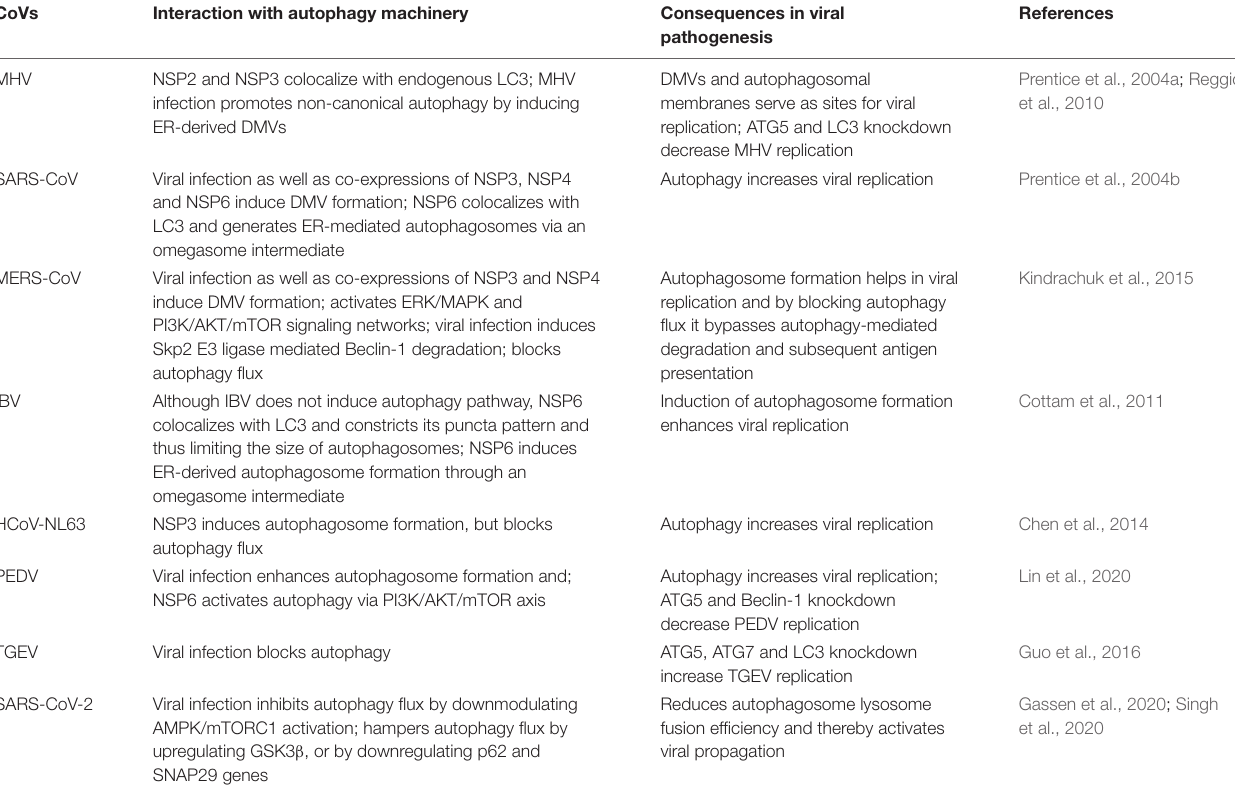
TABLE 1 | Interplay between autophagy and coronaviruses